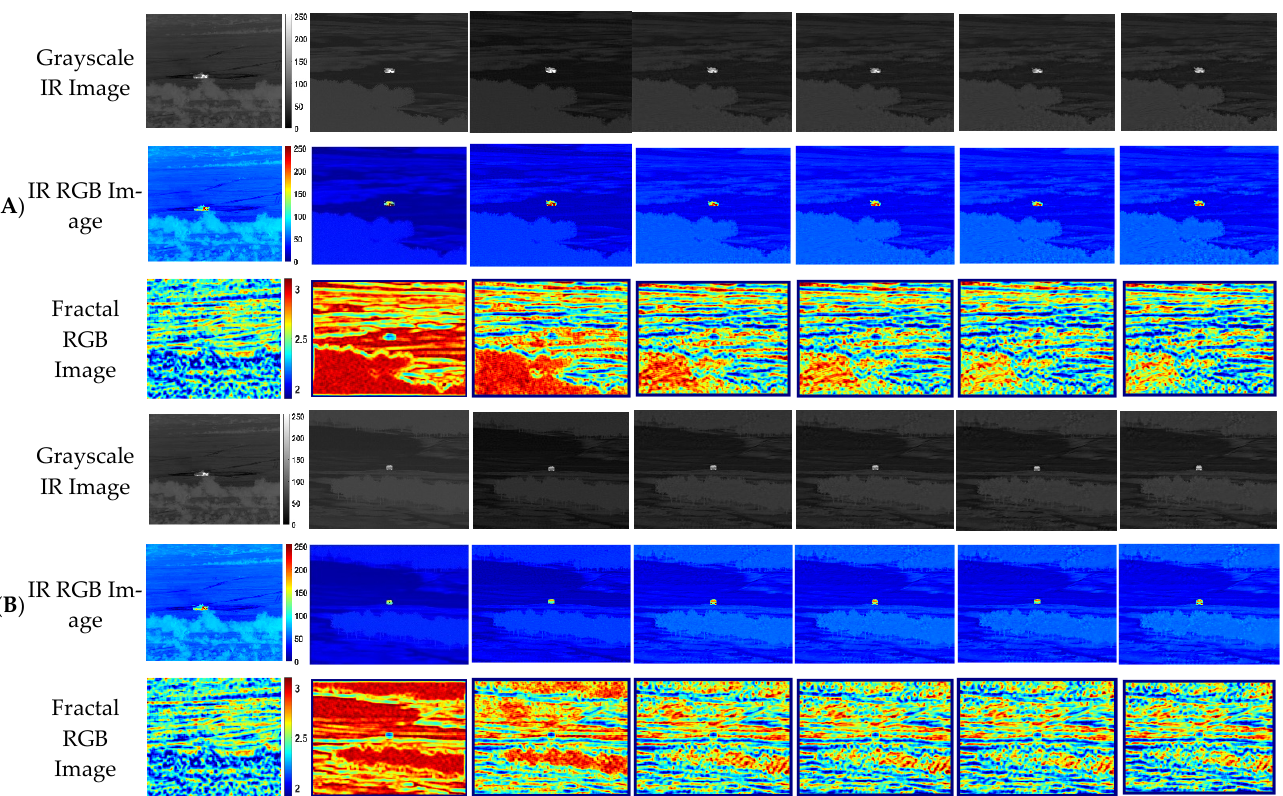
Figure 2. MWIR image examples: ( a ) Simulated infrared image generated with OKTAL-SE [7]; ( b ) Real infrared image from SENSIAC ATR database [32].